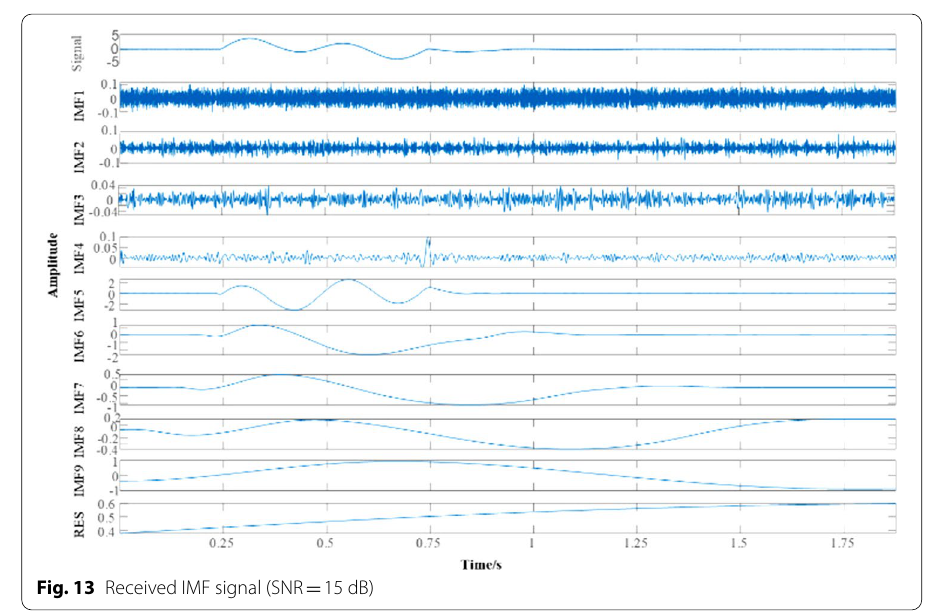
Fig. 13 Received IMF signal (SNR